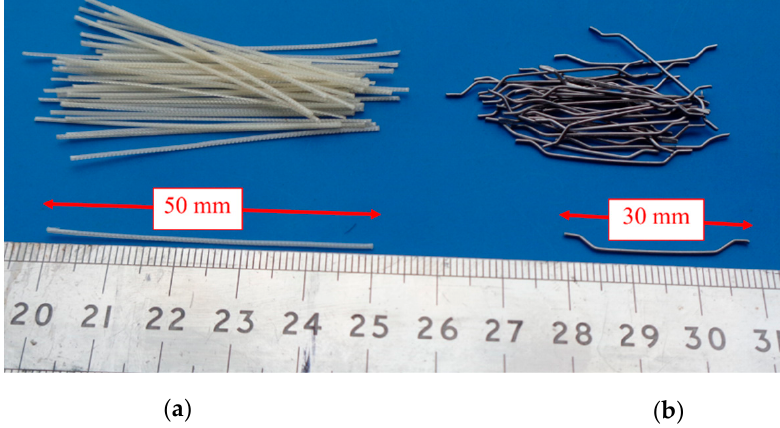
Figure 5. Details of fibers used: ( a ) macro-synthetic fibers, ( b ) hooked end steel fibers. Table 4. Mechanical properties of fibers .